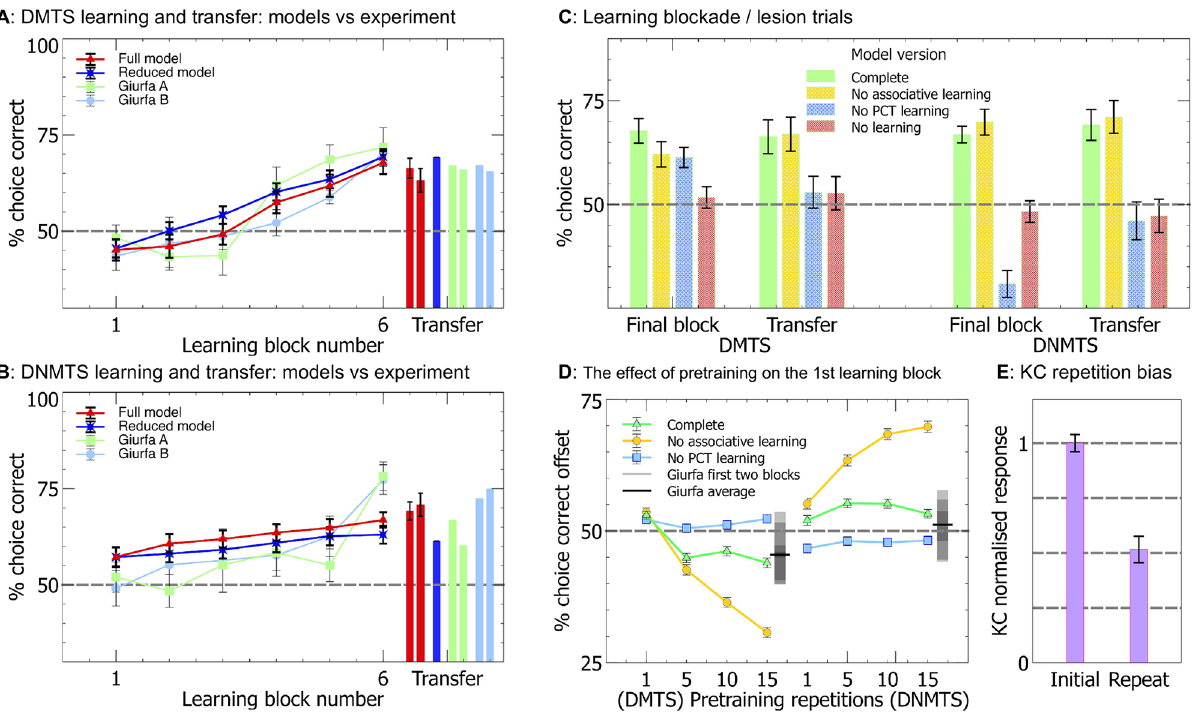
Fig 2. The full and reduced versions of our model reproduce the transfer of sameness and difference learning. A & B The average percentage of correct choices made by the model and real bees within blocks of ten trials as the task is learned (lines), along with the transfer of learning onto novel stimulus sets (bars). Both versions of the model reproduce the pattern of learning acquisition for DMTS (Full: N = 338, Reduced: N = 360) and DNMTS (Full & Reduced: N = 360) found when testing real bees (test for learning: P < 0.0001), along with the transfer of learning (P < 0.0001). For DMTS Giurfa A & B are the data from Experiments 1 & 2 respectively from Giurfa et al. [8], and for DNMTS Giurfa A & B are the data from Experiments 5 & 6 respectively from the same source. For an explanation of the initial offsets from chance for the model please see the text for panel D. C The blockade of plasticity from the MB and PCT pathways shows that the PCT pathway is necessary and sufficient for sameness and difference learning in the full model. All non-overlapping SEM error bars are significantly different. D PCT pathway learning in the absence of associative learning leads to preference for non-matching stimuli following pre-training, demonstrating that learning in the associative pathway changes the form of the sameness and difference acquisition curves. The equivalent offsets and error ranges for the first two blocks of Giurfa Experiments 1, 2, 5 & 6 along with the averages for DMTS and DNMTS for these blocks are shown alongside the model data for comparison as overlapping grey boxes—overlapping boxes create darker regions, thus the area of greatest darkness is the point where the most of the error ranges overlap. E The average activity of the model KC neurons when presented with repeated